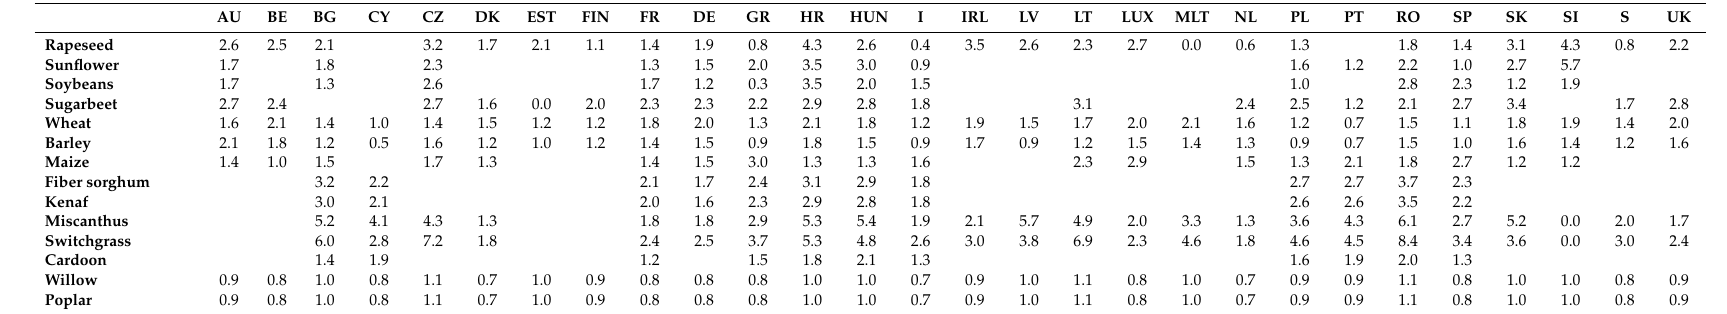
Table A12. Profitability Index in low quality